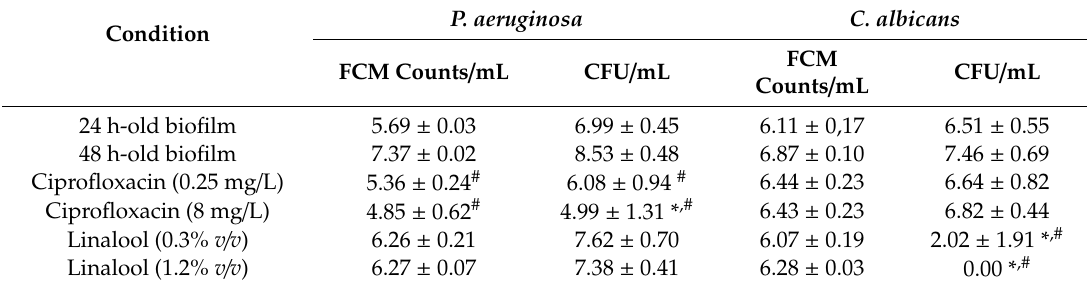
Table 1. FCM counting and colony-forming units (CFU) enumeration of pre-established mixed biofilms treated with two di ff erent concentrations of ciprofloxacin and linalool. Both 24 and 48 h-old untreated biofilms are included for comparison purposes. Log 10 values represent means ± standard deviations